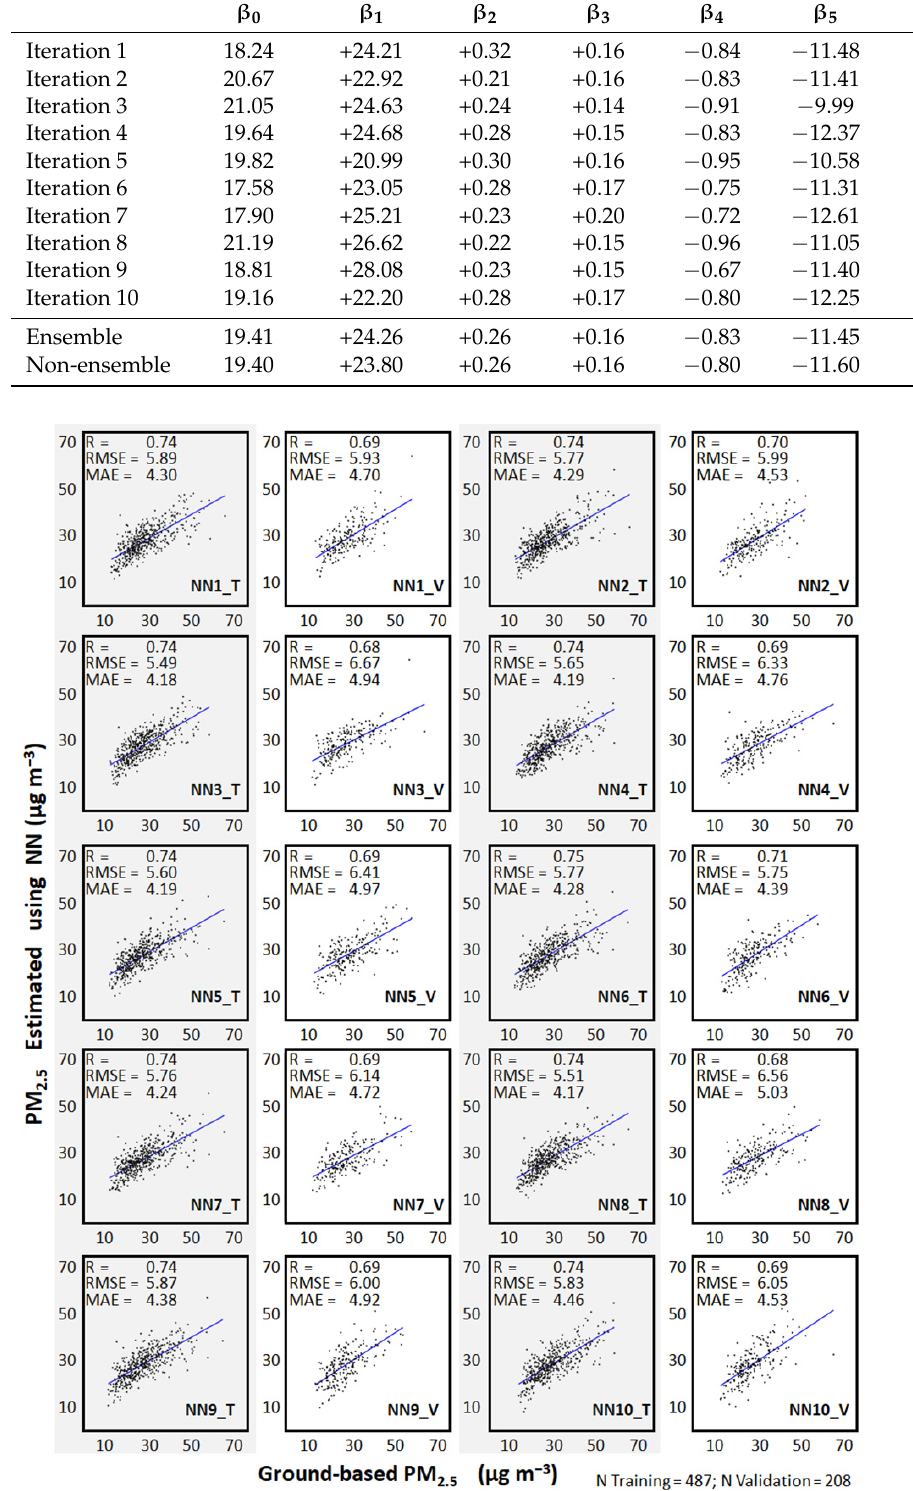
Figure 5. Statistical performance of each of the 10 NNs used to construct the ensemble NN (ENN) for the estimation of the daily mean PM 2.5 using the best dataset over the MMA from January 2010 to December 2017. Training (T) and validation (V) dataset results are presented. The ground-based PM 2.5 and the EMLR-estimated PM 2.5 (Figure 6a) exhibited a mod- erate but statistically significant correlation at the 95% confidence level ( R = 0.57, RMSE = 7.00 μ g m − 3 , and MAE = 5.29 μ g m − 3 ). The ENN model improved the EMLR PM 2.5 estima- tions (Figure 6b), with the following performance: R = 0.78, RMSE = 5.43 μ g m − 3 , and MAE = 3.98 μ g m − 3 .